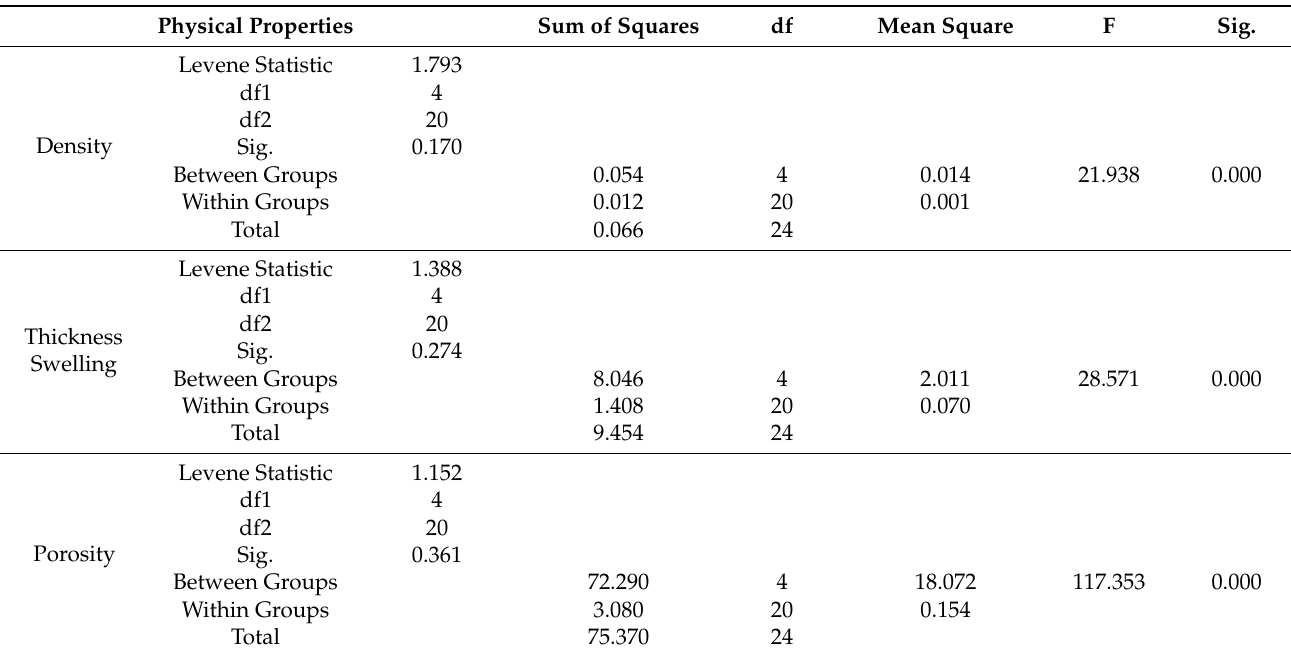
Table A3. Analysis of variance for physical properties with various milling times.